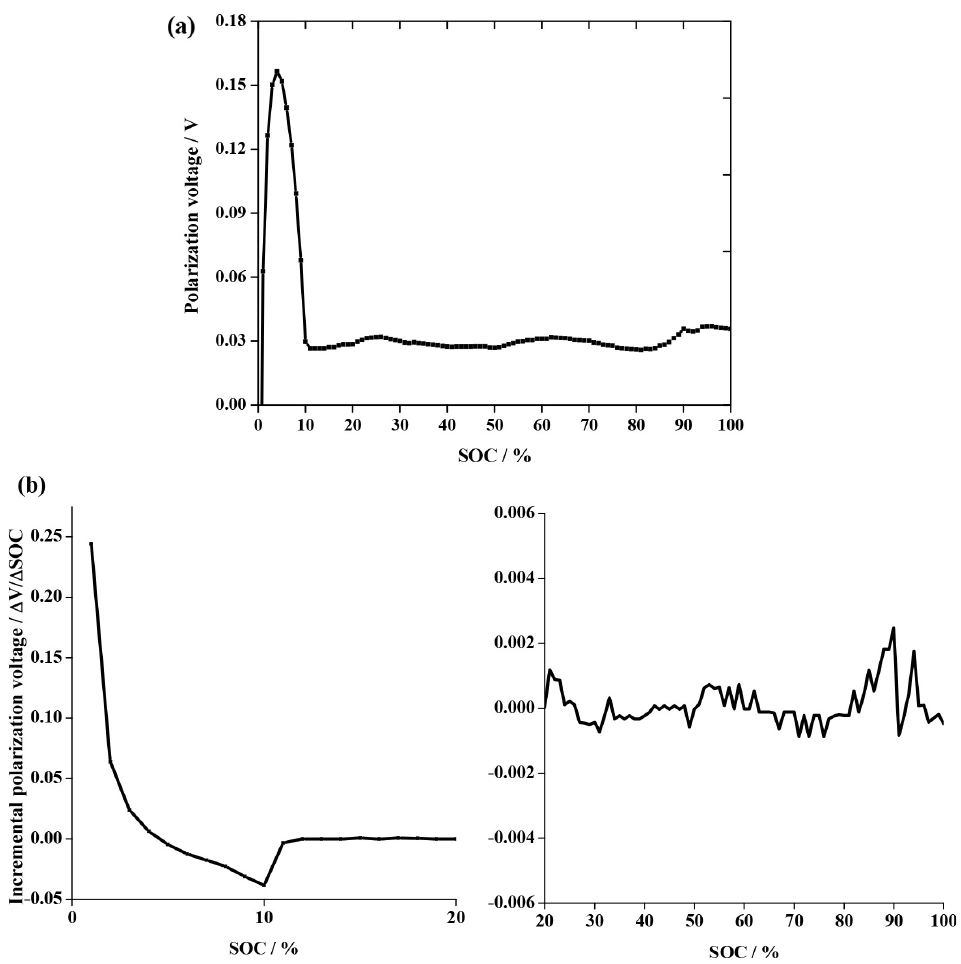
Figure 4. (a) Battery charge polarization voltage variation with SOC; (b) Incremental charge polarization voltage as a function of